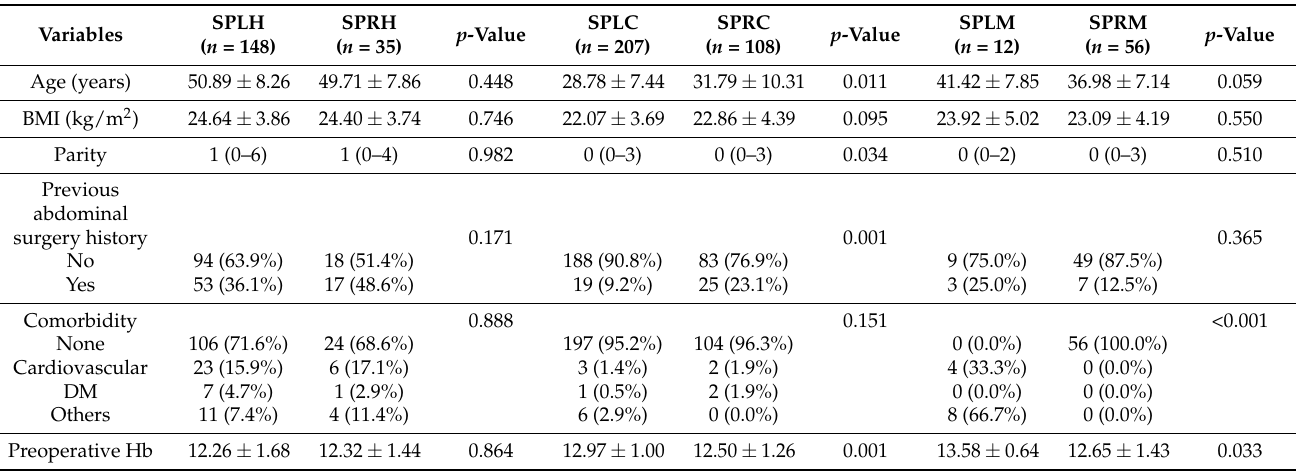
Table 1. The patients’ characteristics of SPLH, SPRH, SPLC, SPRC, SPLM, and SPRM groups.